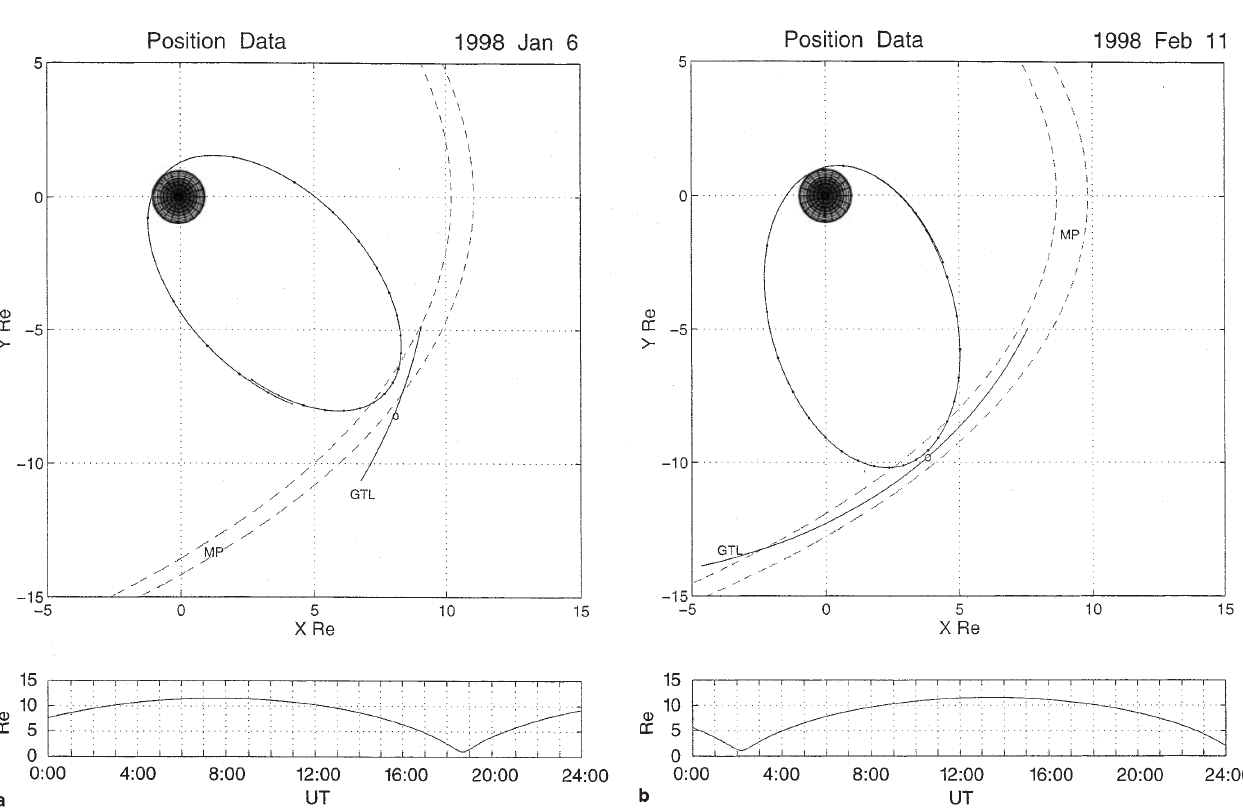
closest approach ( circle ). Note that Equator-S moves anticlockwise around the orbit and the lower panel gives radial distance from the Earth over